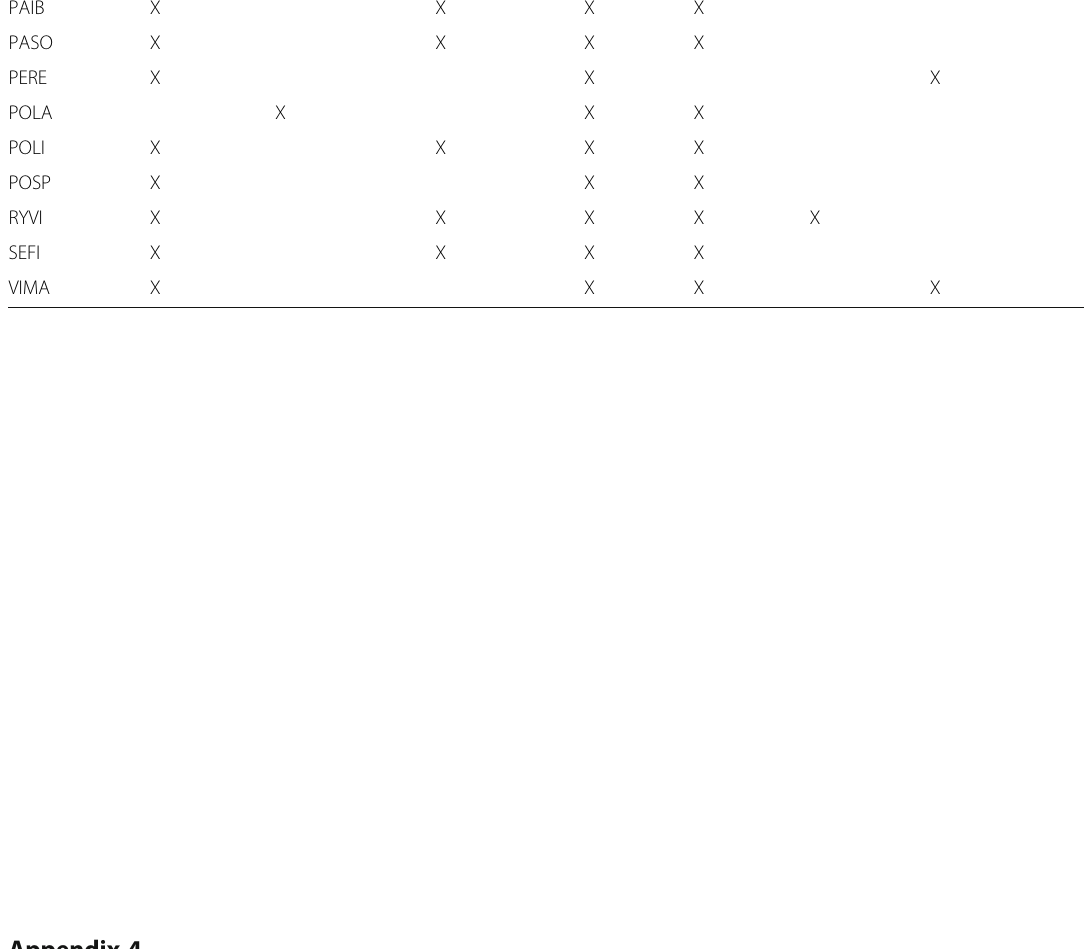
Table 5 Correlation indices among the variables used in the modelling of the potential habitat suitability of plant species in Santa Cruz Province. Significant correlation values (> 0.80) were identified with one asterisk